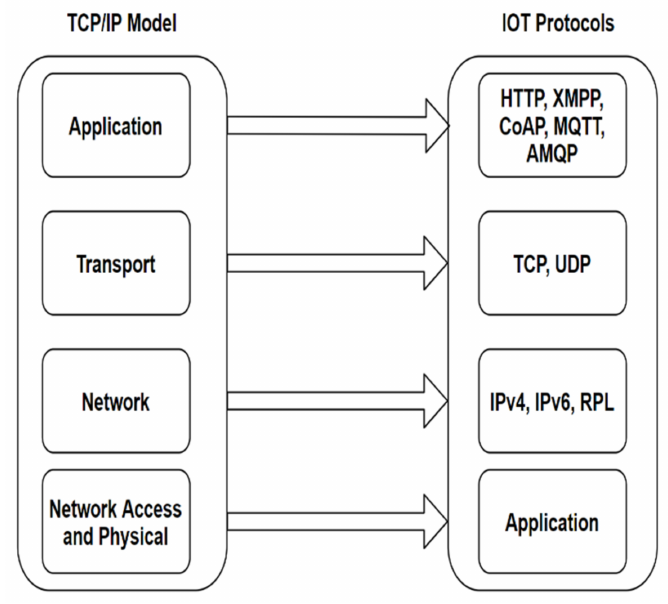
Figure 1. TCP/IP model and IoT